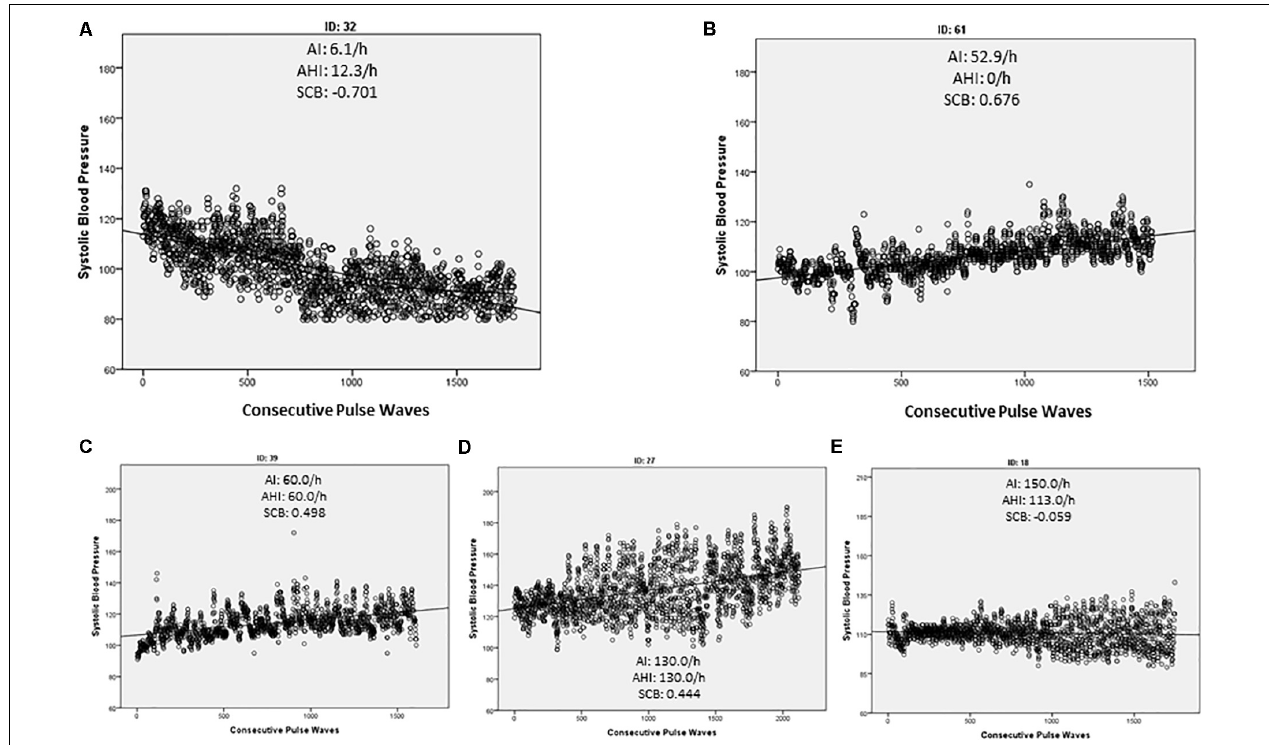
FIGURE 1 | Simple dot blot of each measured pulse wave against the corresponding systolic blood pressure (SBP). The regression line indicates the general direction of the SBP during the observed time period. Arousal index (AI), apnea/hypopnea index, and the calculated standardized coefficient β (SCB) of each demonstrated example are indicated. In controls we found mainly a negative SCB indicating a decrease in the SBP (A) while patients with OSA tended to increase the SCB (C,D) . However, an increase in the SBP was also detected in the absence of a significant OSA (AHI > 15/h) if sleep fragmentation was present (B) . In some OSA patients, the SCB kept stable and only the variance of the SBP increased (E)